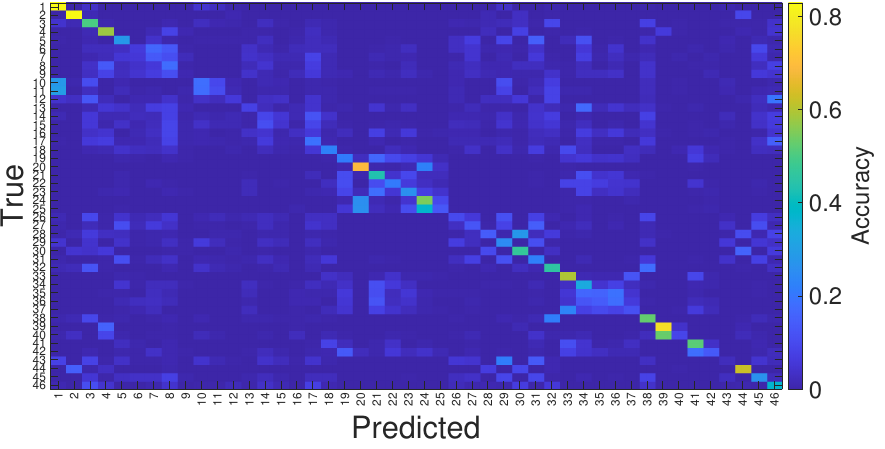
Figure 14. Confusion matrix with WHT and Opt seg = 32 at SNR = 0